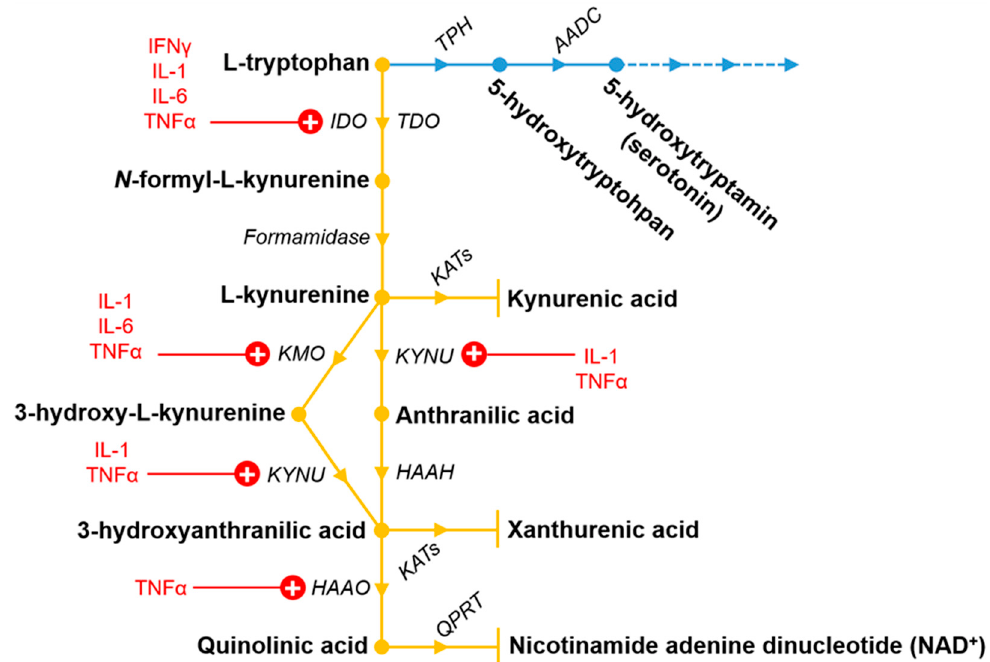
Figure 1. The tryptophan metabolic pathway including the kynurenine (yellow) and partly the serotonin pathway (blue). Pro-inflammatory cytokines discussed in this review which upregulate (highlighted by “+”) the different enzymes are also indicated in red. For further information, see Section 4 and Table 2. Metabolites and enzymes of the pathways are shown in bold and italic, respectively. The dashed lines in the serotonin pathway indicates the further continuation of the pathway, which is not discussed here. Abbreviations: AADC: aromatic acid decarboxylase enzymes; HAAH: